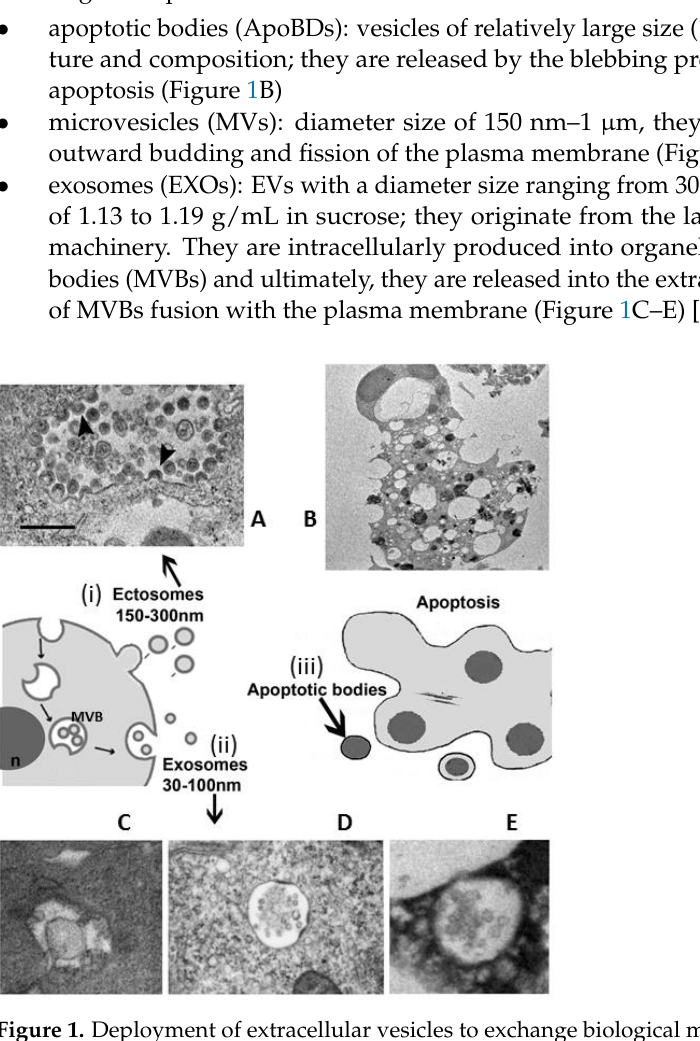
Figure 1. Deployment of extracellular vesicles to exchange biological molecules contained within a membrane boundary. (i) Budding of microvesicles off the plasma membrane (ectosomes or microvesicles); (ii) release of exosomes through the fusion of multivesicular bodies (MVBs) with the plasma membrane; (iii) blebbing off of larger vesicles, especially from apoptotic cells (apoptotic bodies). In the upper side there are representative transmission electron images: ( A ) microvesicles liberation (arrowheads), and ( B ) an apoptotic cell. In the bottom side: ( C ) inward invaginations of the MVB indicate the beginning of exosomes biogenesis, ( D ) MVB enclosing a lot of exosomes, and ( E ) MVB near to fuse with the membrane. n = nucleus.